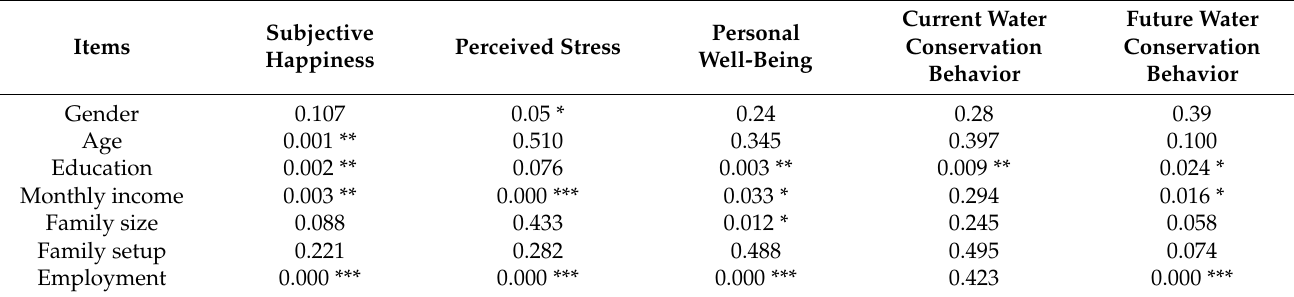
Table 2. Descriptive statistical analysis.